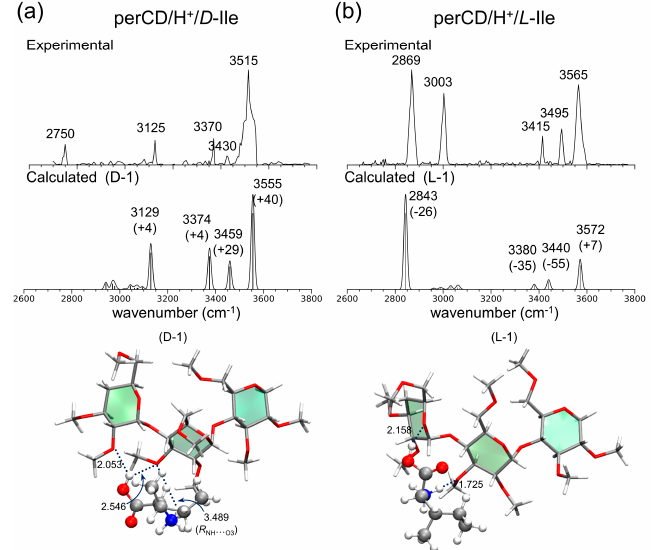
Figure 14. Experimental IRMPD and calculated IR spectra of ( a ) per- β -CD/H + /D-Ile and ( b ) /L-Ile complexes with the associated structures. Reproduced from Reference [60] by permission of the PCCP Owner Societies.